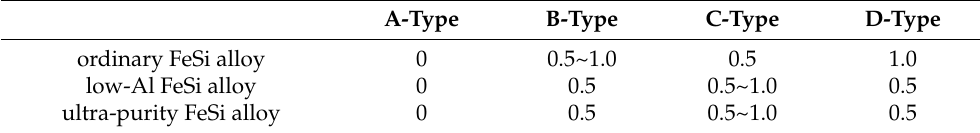
Table 4. Rating results of inclusion in hot rolled plate corresponding to different ferrosilicon alloys.